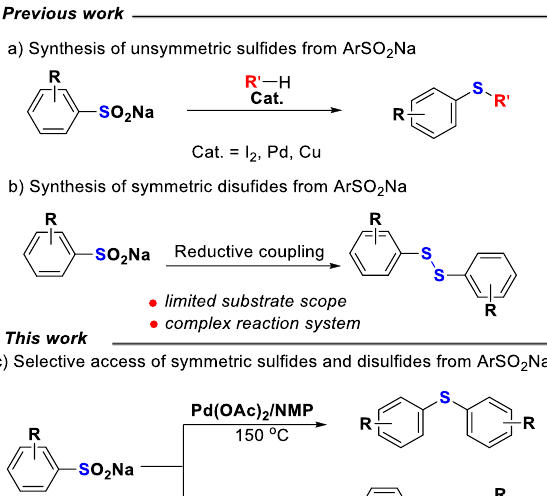
Scheme 1. Sulfides and disulfides construction from sodium sulfinates.